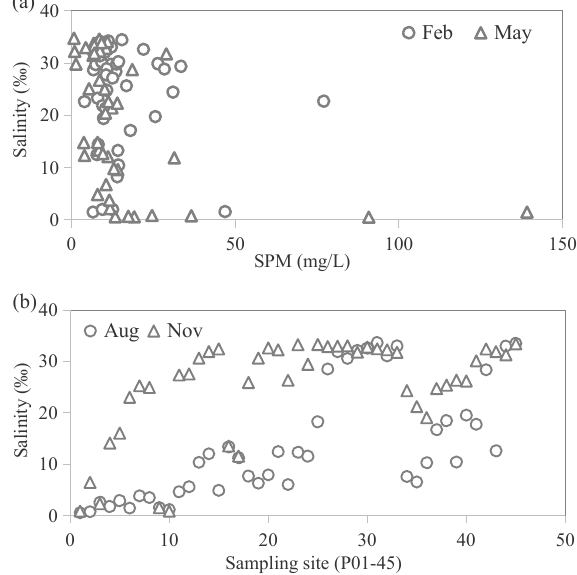
Figure 3. Seasonal variations of salinity and suspended particulate matter in the surface waters of the Pearl River estuary (( a ) February, May; ( b ) August, November), no SPM data in August and